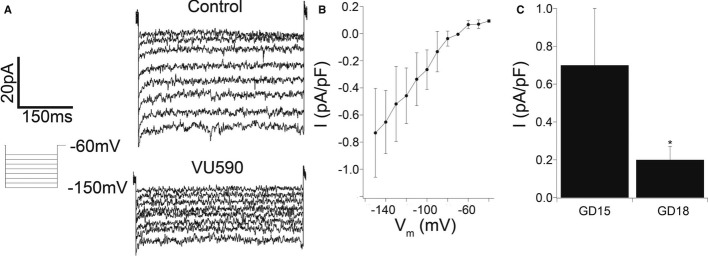
Kir7.1 current in uterine myocytes decreases from mid-pregnancy to termMeasurement of inwardly rectifying, VU590-sensitive current in freshly dissociated GD15 murine myometrial cells. Shown are voltage-clamp recordings in the presence and absence of 10 μM VU590.Current-voltage relation (n = 5; mean ± SD, per data point) of current density [VU590 subtracted from control (vehicle alone)].Current density (pA/pF) at −150 mV and 500 ms in freshly dissociated murine myometrial cells from GD15 and GD18 (n = 5 mean ± SD, per GD). *P < 0.05, Student's t-test.